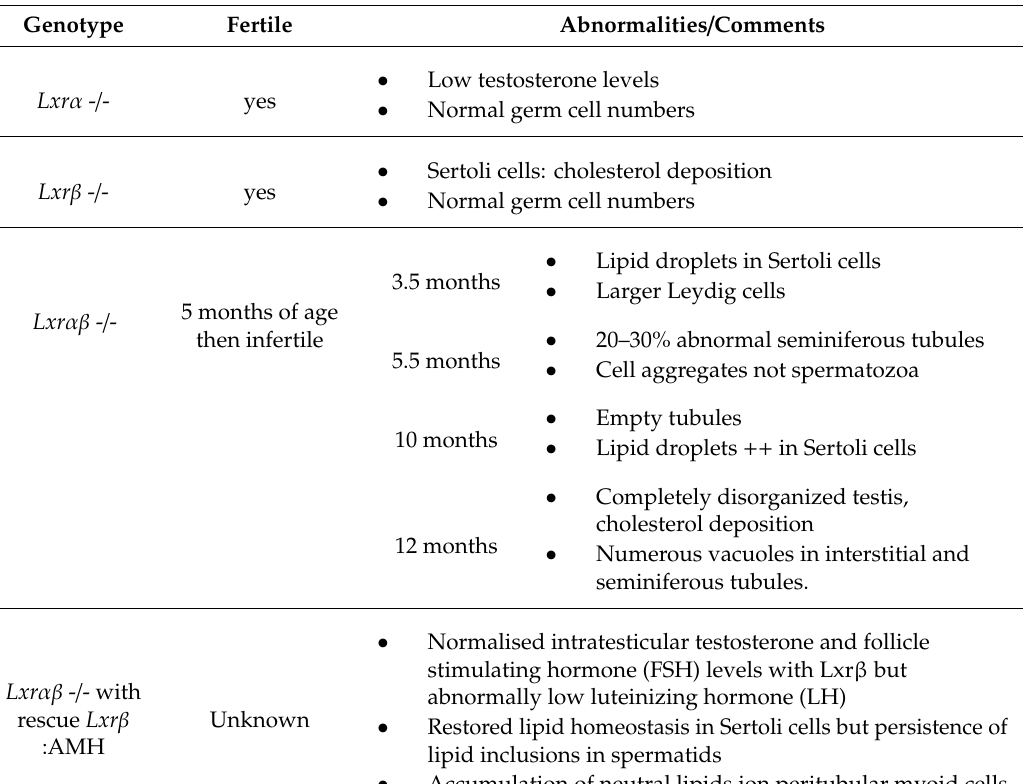
Table 1. Summary of defects reported in LXR knockout mice [18,73] and e ff ects of rescuing Lxr β in Sertoli cells